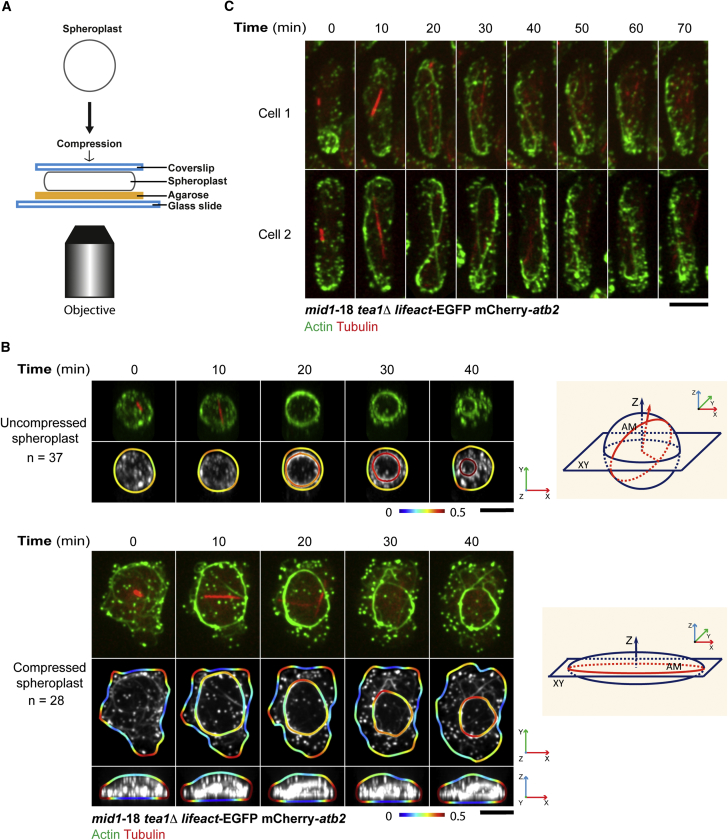
Assembly of Actomyosin Rings in Compressed mid1-18 tea1Δ Spheroplasts(A) A diagram illustrating an overview of the compression of spheroplasts by sandwiching and pressing spheroplasts between a coverslip and an agarose pad.(B) Assembly of rings at the larger cell circumference in compressed mid1-18 tea1Δ spheroplasts. The top two panels are uncompressed spheroplasts (n = 37). The bottom three panels are compressed spheroplasts (n = 28). Curvatures of the ring and spheroplast circumferences are colored coded with the rainbow look-up table. For the uncompressed spheroplasts, the image was rotated so that the ring was parallel to the imaging plane for curvature measurement. The projection axes of the displayed images are indicated by the arrows labeled with x-y-z. The two diagrams illustrate the imaging axes. AM, actomyosin ring. See also Movie S5.(C) Actin dynamics in mid1-18 tea1Δ cells expressing LifeAct-EGFP and mCherry-Atb2. Two examples are shown.Scale bars, 5 μm.